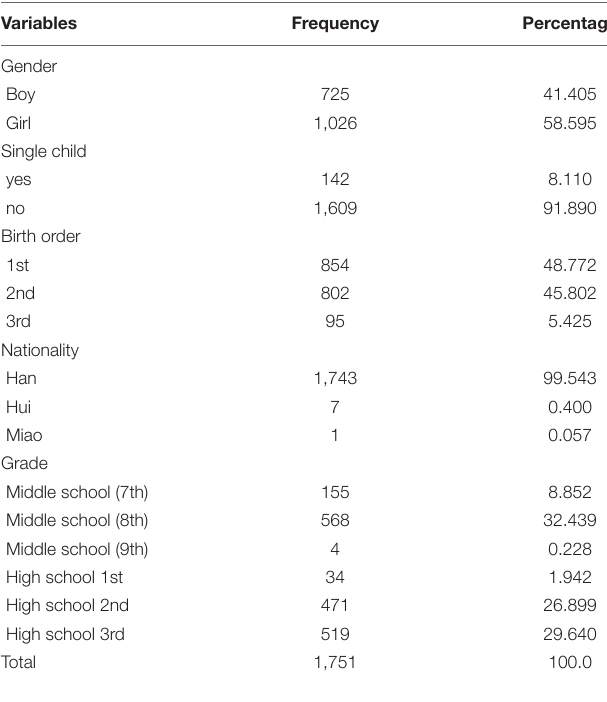
TABLE 1 | Demographic profiles and descriptive statistics of the